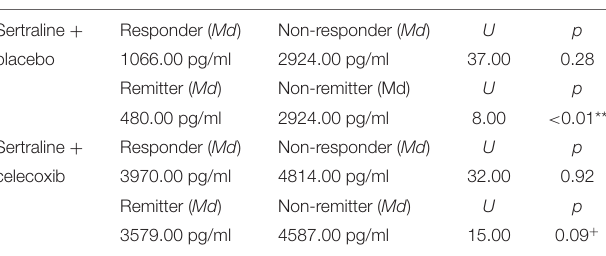
TABLE 4B | Comparison of endpoint MIF levels of different response statuses in the two treatment arms.